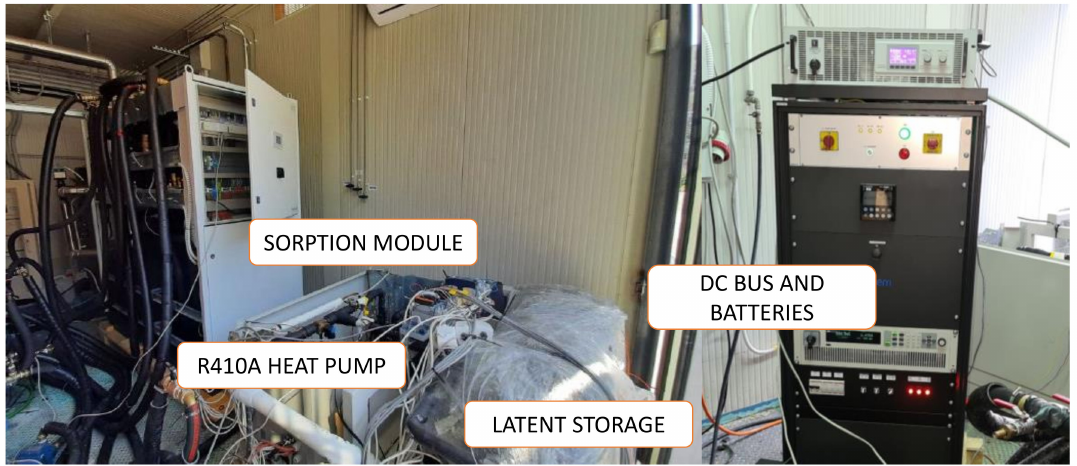
Figure 2. HYBUILD system installed in the laboratory of CNR